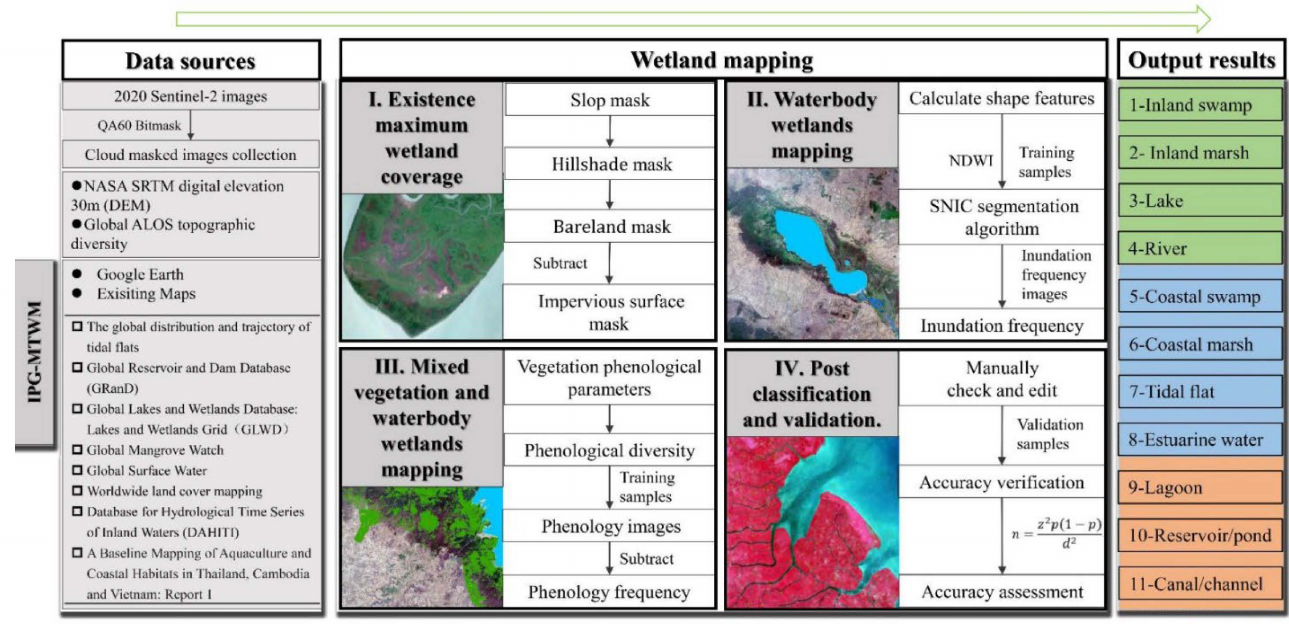
Figure 3. The schematic flowchart of IPG- MTWM